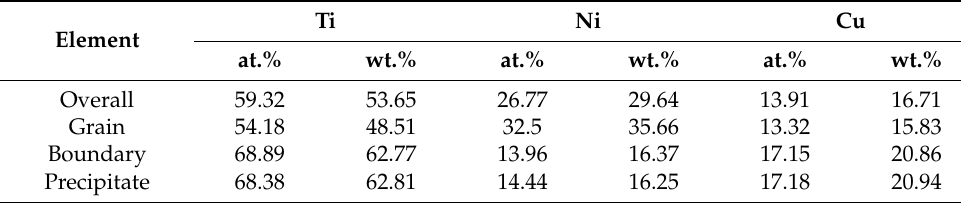
Table 2. Compositional analysis of the Ti-Ni-Cu target.